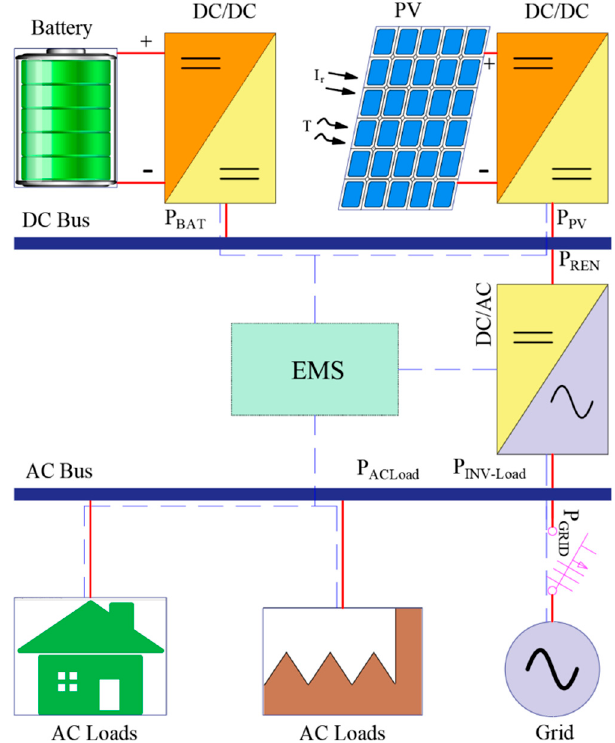
Figure 2. The architecture of the microgrid system. Solar PV module performance is affected by irradiation, pollution, aging, shading and ambient temperature. Since the aim of this study is not maximum power point